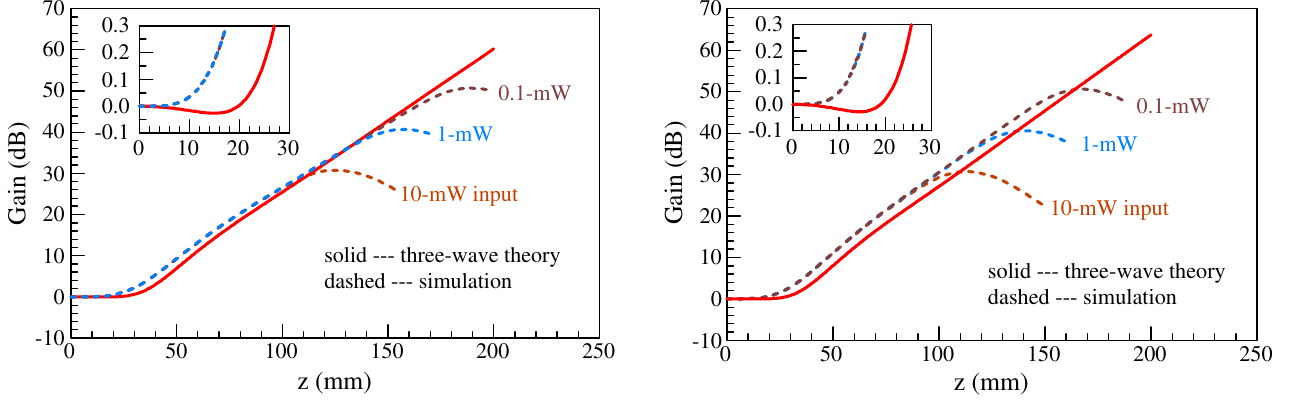
FIG. 3. (Color) Gain profile from Pierce three-wave theory (solid) compared with the ones from particle simulations (dashed) for 0.1-mW, 1-mW, and 10-mW input rf powers. Three-wave theory: 30-keV, 25-mA cold line beam; simulation: 30.2-keV, 25-mA cold line beam. The gains from simulations are positive in the initial beam-wave interaction process while the gain from Pierce three-wave theory is